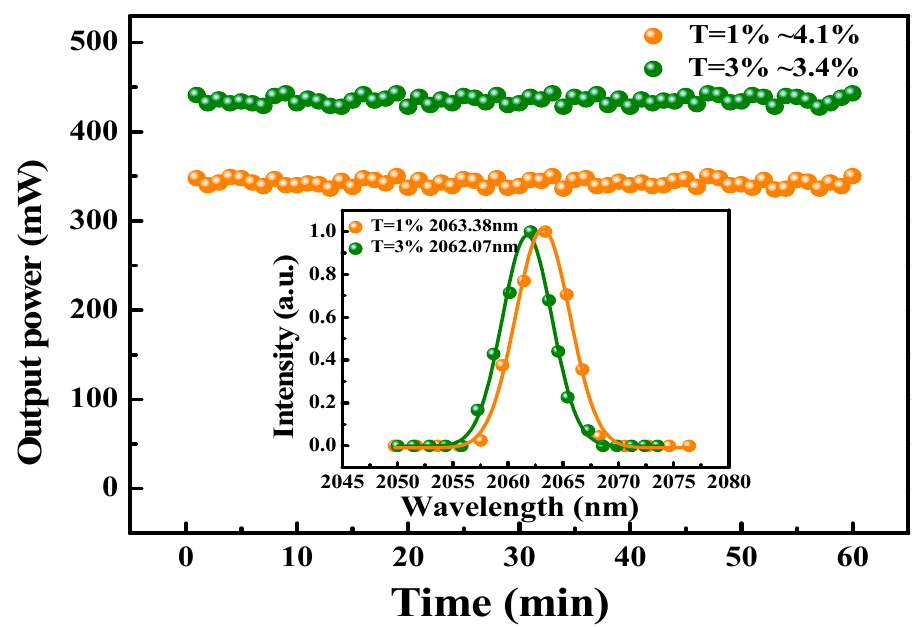
Figure 5. Instability of the average output power measured for 60 min with output couplers (OCs), inset: PQS laser emission spectra for two different OCs.